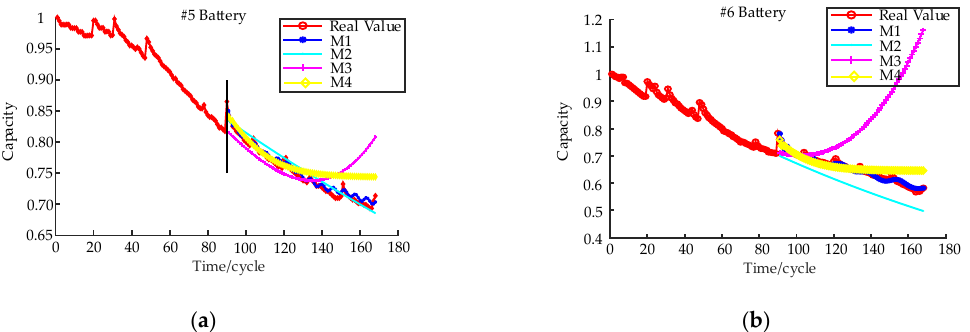
Figure 8. The comparisons for four models (M1 – M4): ( a ) #5 battery; ( b ) #6 battery.